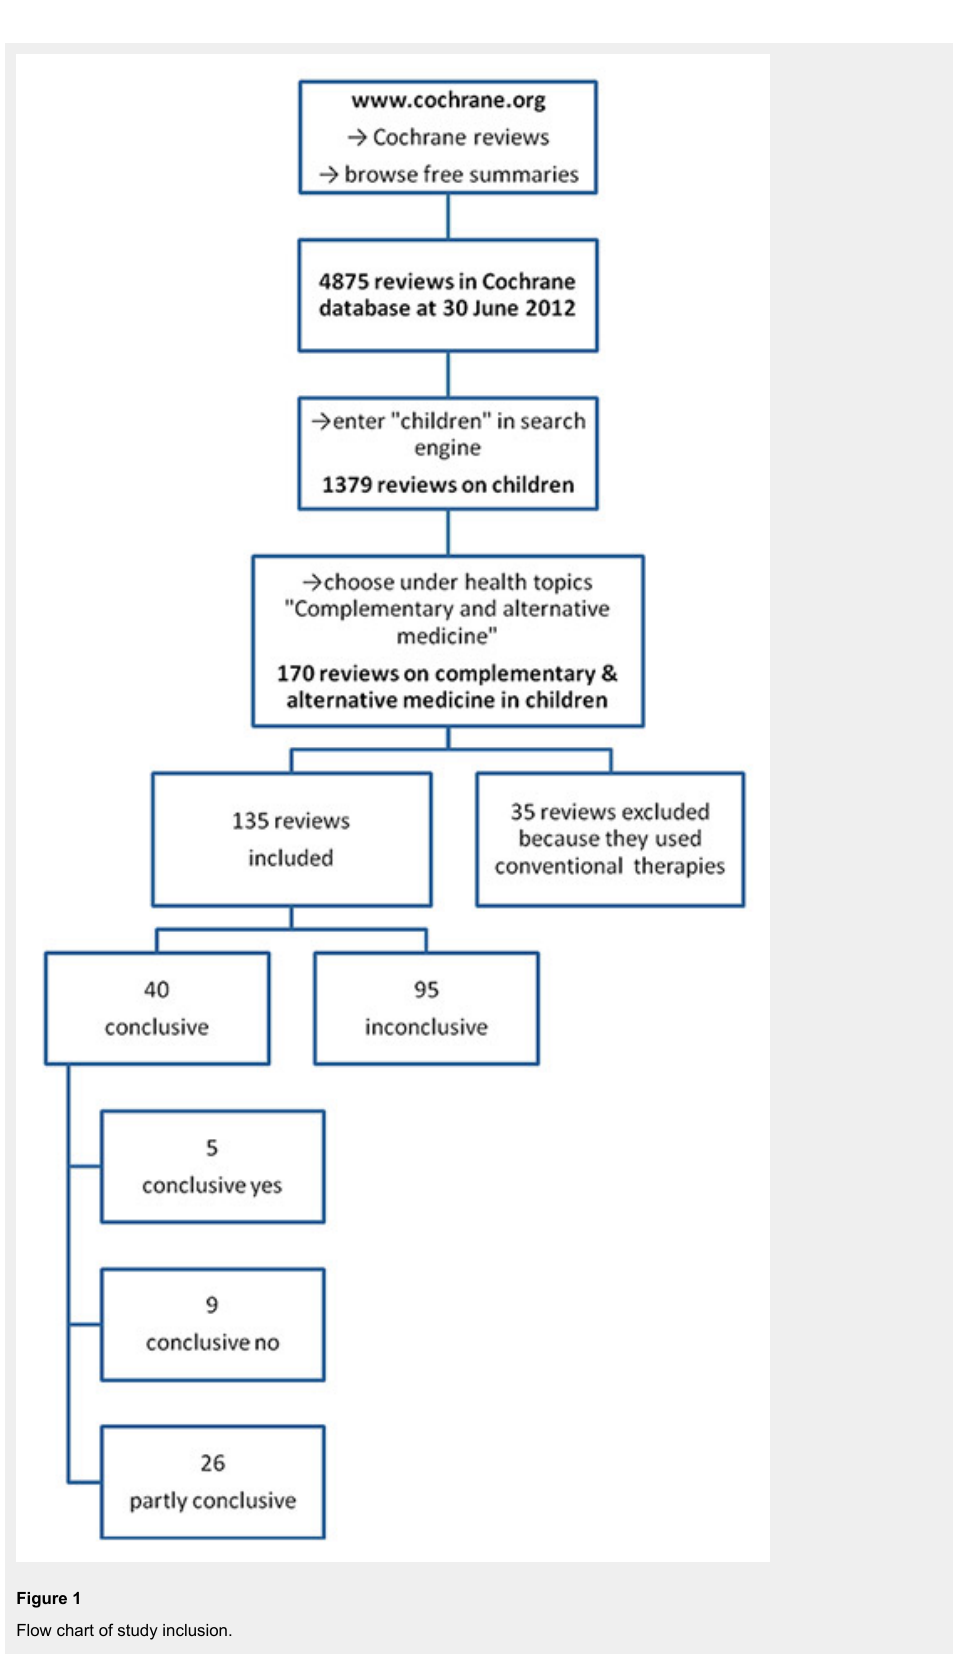
Figure 1 Flow chart of study